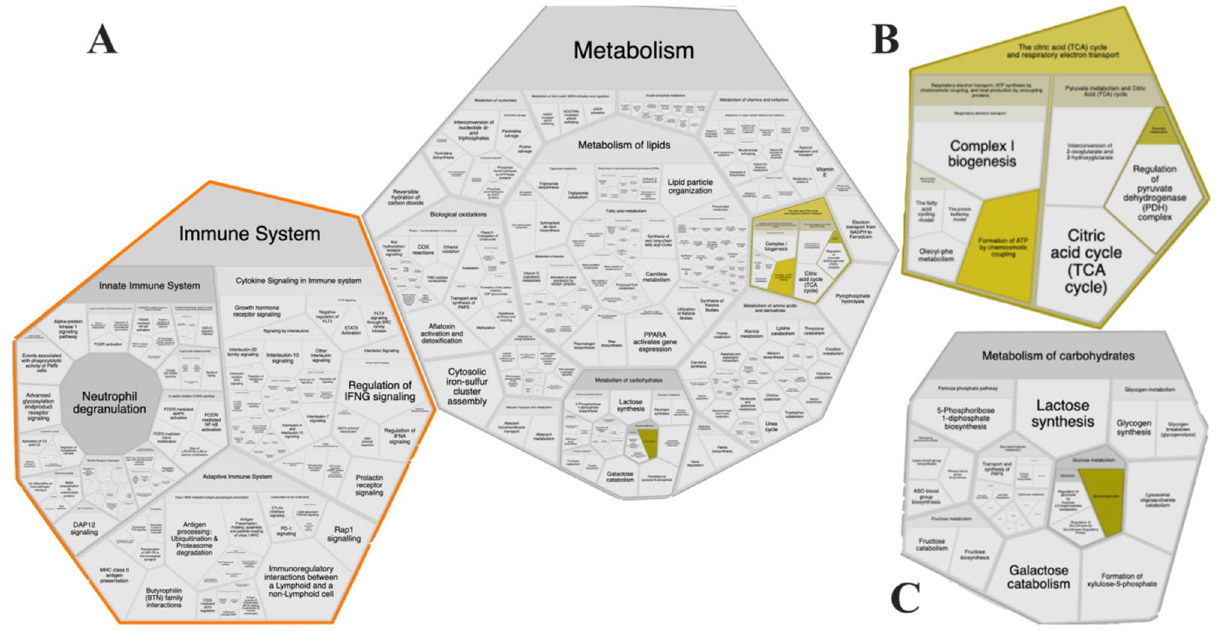
Figure 1. Affected pathways generated from KEGG ID input using Reactome show that immune system and metabolism is impacted ( A ), which, glycolysis and gluconeogenesis ( B ) and metabolism of carbohydrates ( C